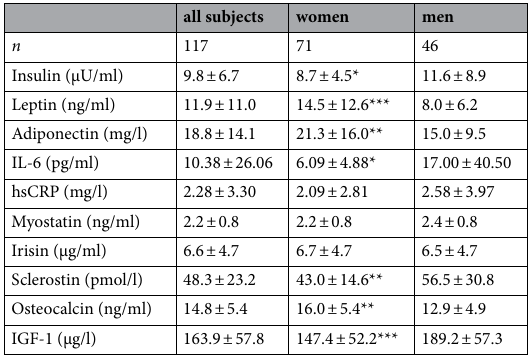
Table 2. Levels of hormones, growth factors and inflammation markers in the total population and in the subgroups of men and women. Values are means ± SD. IL-6 , interleukin 6; hsCRP , high-sensitivity C-reactive protein; IGF-1 , insulin-like growth factor 1. *p < 0.05, **p < 0.01, ***p < 0.001 sex differences by t -test.